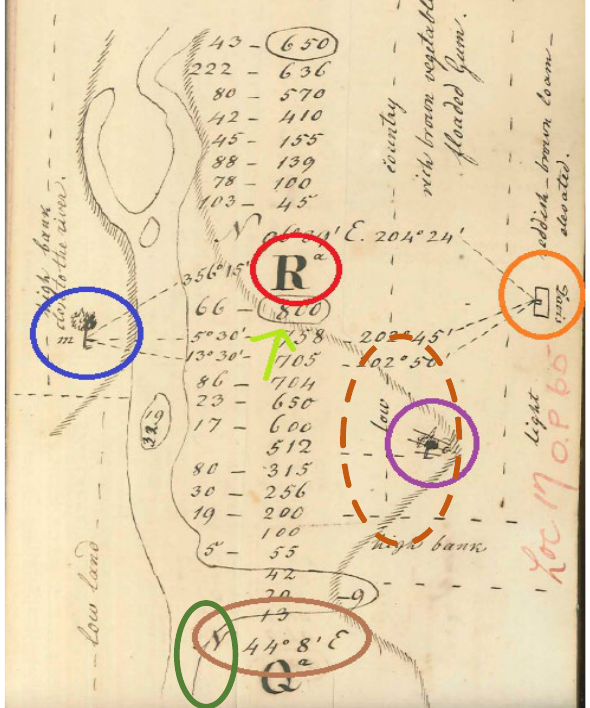
Figure 1: Field sheet of Preiss' survey of the Canning River. It was possible to re-draw the location of the river and any points of interest using a standard surveying software (in this case MAGNET (Topcon, 2020)).